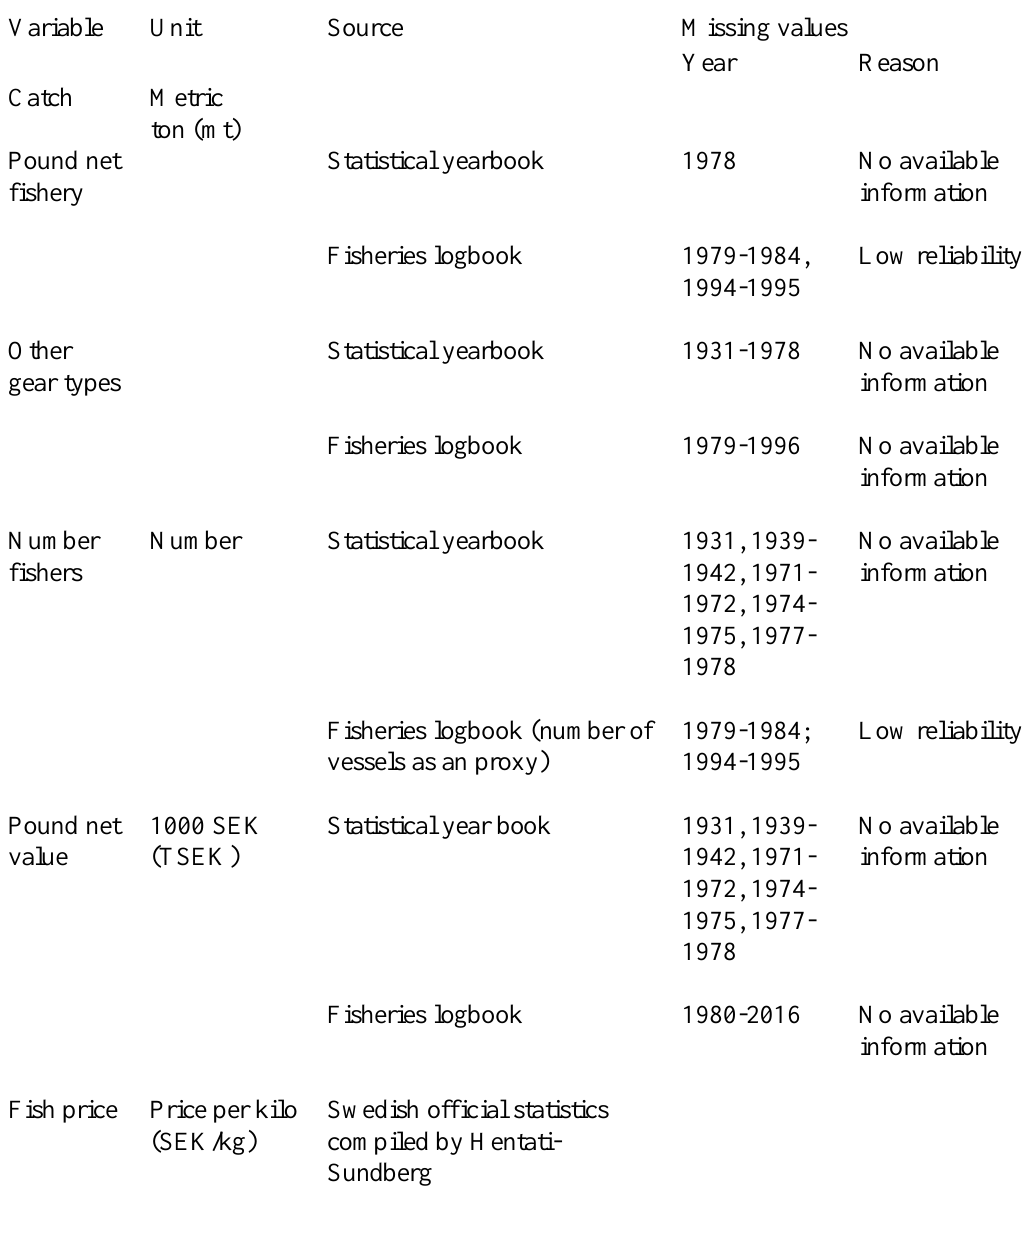
Table A1.1. Overview of the statistical material. Pound net value and price per kilo fish were compensated for inflation using the Swedish Consumer Price Index